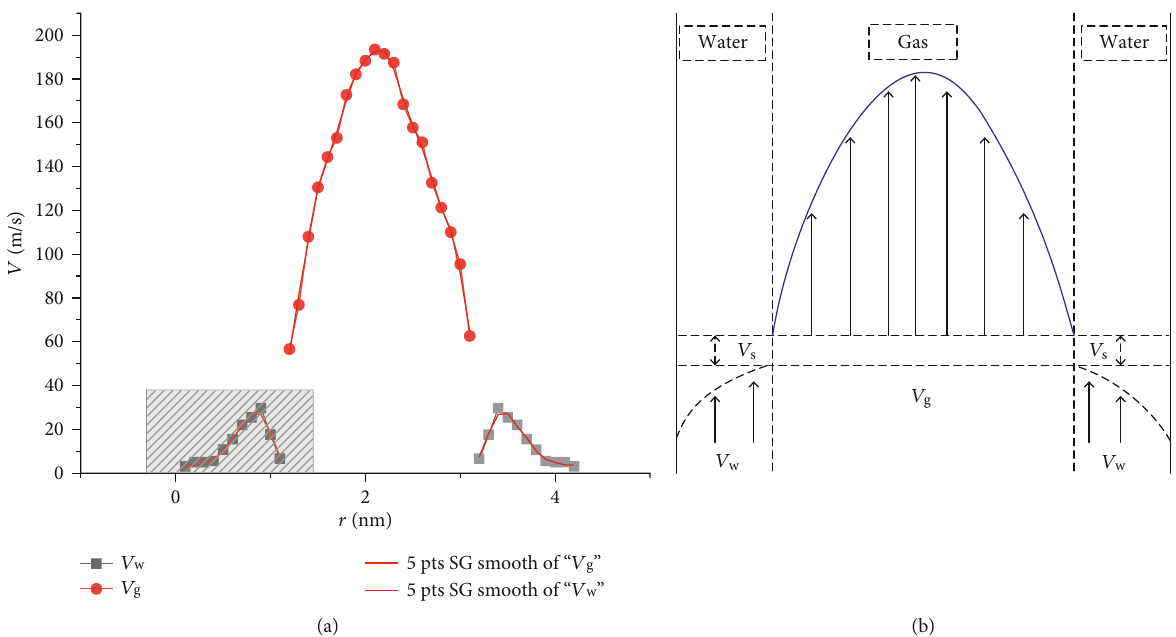
Figure 1: Comparison of velocity pro fi le between molecular dynamics simulation results and the results only considering the slip velocity of gas and water. (a) Molecular dynamics simulation results of gas and water velocity in nanometer pores. T = 333 : 15 K, P = 207 MPa, r L = 7 : 23 cm, θ = 30 ° . (b) Schematic view of the gas and water velocity which considers the slip velocity of gas and water. v